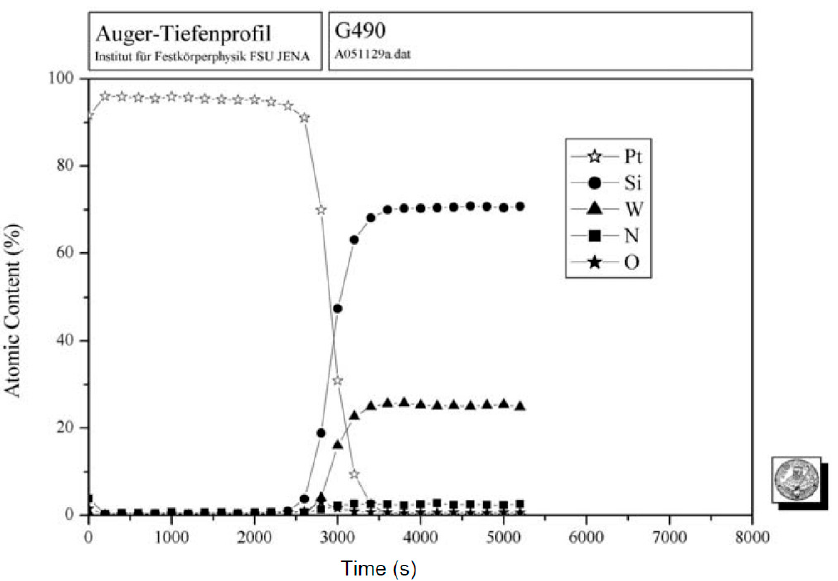
Figure 6. Auger electron spectroscopy (AES) analysis of a sample with a WSiN barrier layer and 150 nm Pt top metallization, annealed for 1050 h at 500 °C in N 2 ambient conditions.